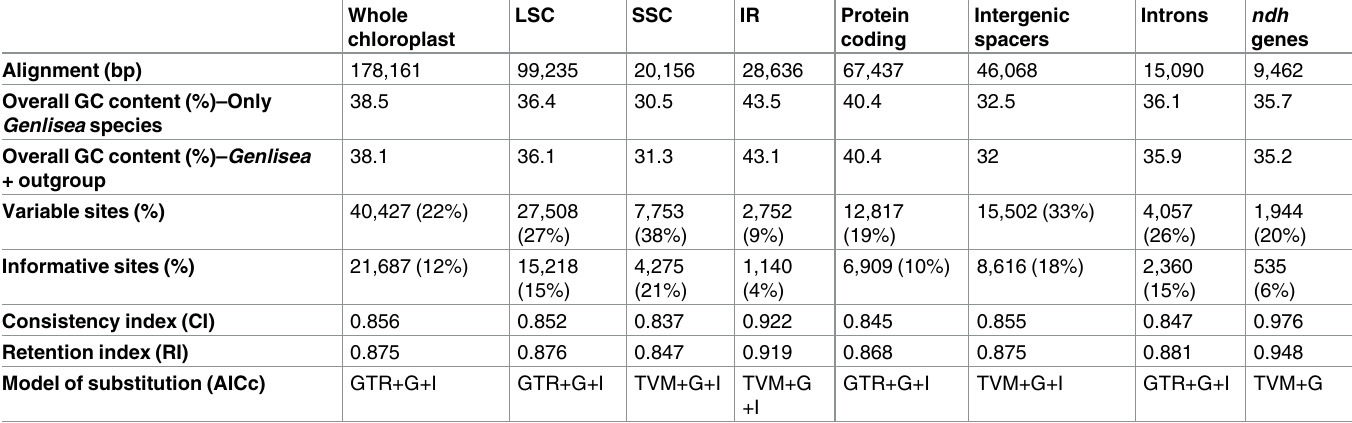
Table 3. Datasetsand phylogenetic statistics for each Genlisea cpDNA partition.